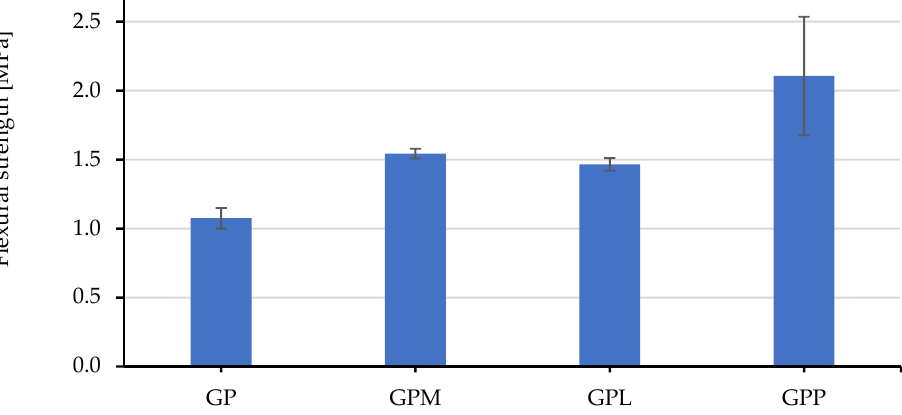
Figure 6. The flexural strengths of the samples compared to GP.